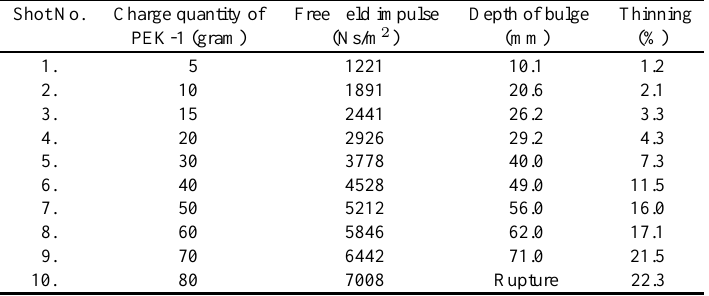
Table 5 Summary of results of plastic deformation experiments on circular plates; stand off = 15 cm Shot No. Charge quantity of Free field impulse Depth of bulge